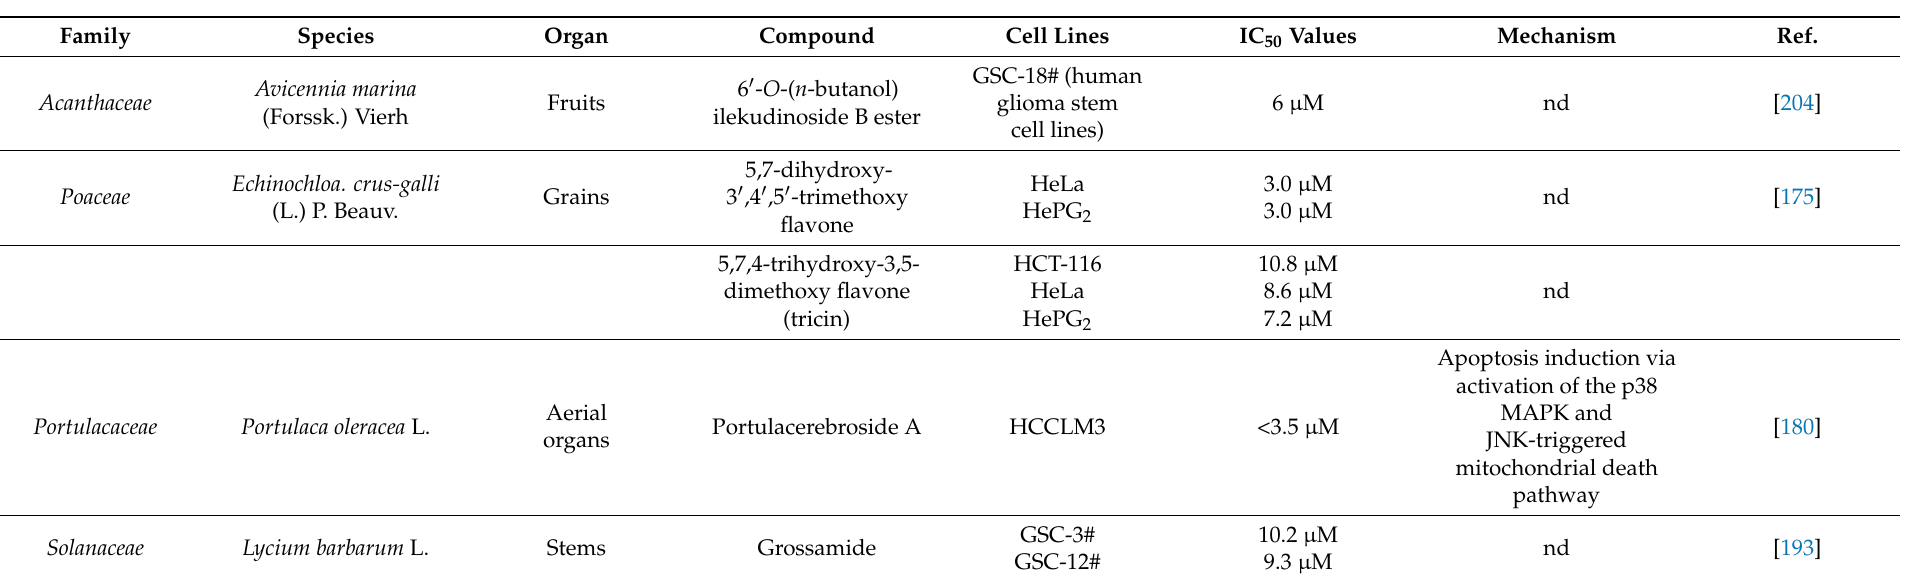
Table 4. Cytotoxic activity of selected isolated compounds from halophytes species, including cell lines tested, obtained IC 50 values, and proposed mechanisms of action. The criterion of cytotoxic activity for the isolated compounds was an IC 50 value ≤ 10 µ M, according to the National Institutes of Health (NIH) for screening the NCI60 program